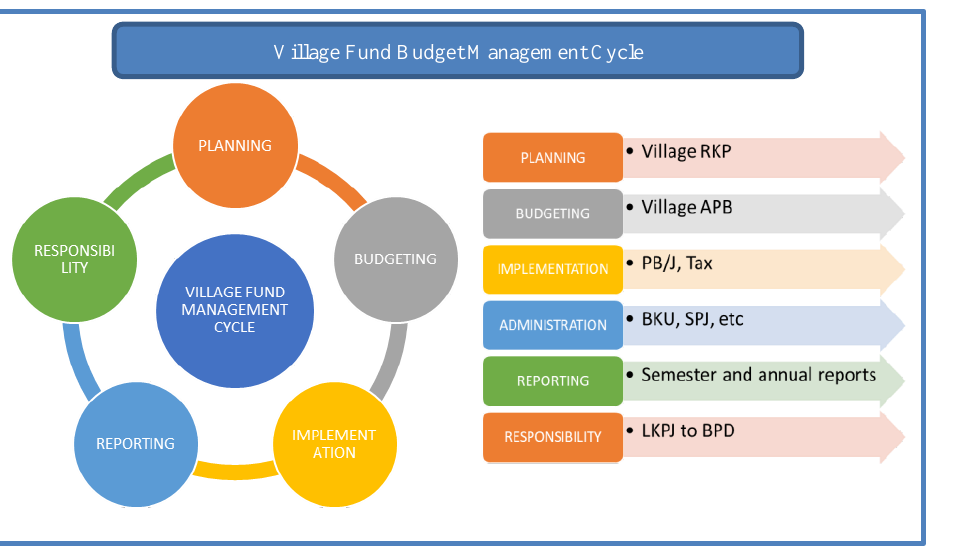
Figure 1 : The Cycle of Village Fund Management